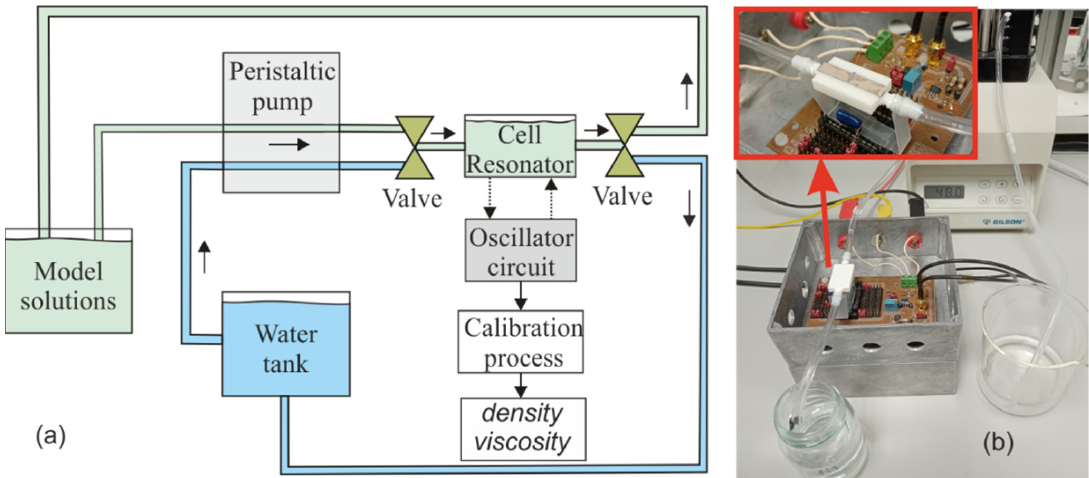
Figure 15. ( a ) Schematic and ( b ) photograph of the setup for the real-time monitoring of model solutions of a grape must fermentation process. Piezoelectric actuators are shown in the inset to ( b ).